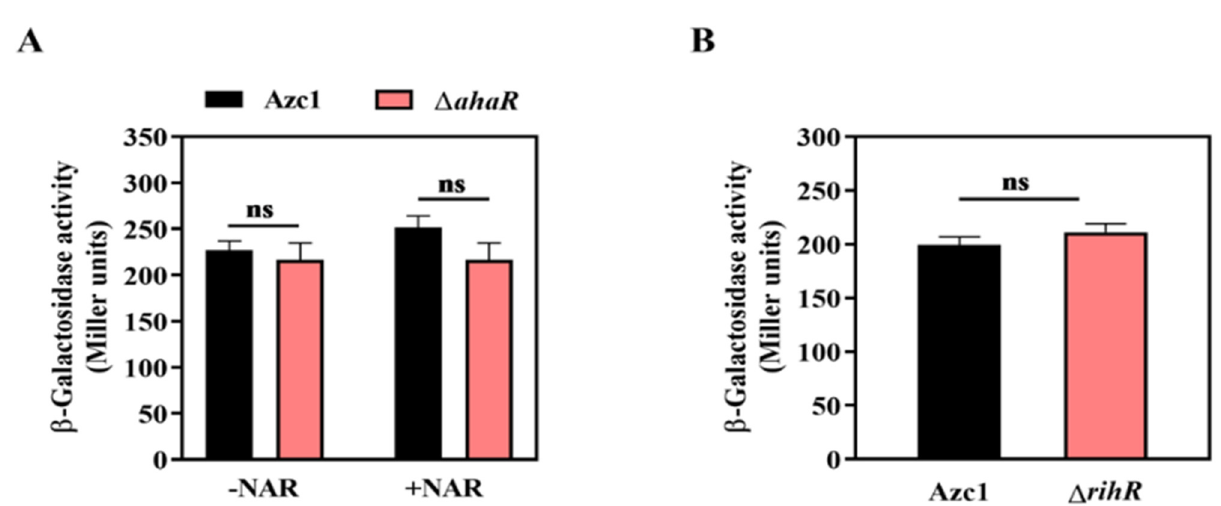
Figure 6. The regulatory relationship between rihR and ahaR of A. caulinodans . ( A ) The β -galactosidase activities of the translational fusion rihR - lacZ was determined in Azc1 and ∆ ahaR . When indicated, 20 µ M NAR was added to the medium. ( B ) The β -galactosidase activities of the translational fusion ahaR - lacZ were measured in Azc1 and ∆ rihR . Data are mean ± SD of three independent experiments. ns: no significant difference.